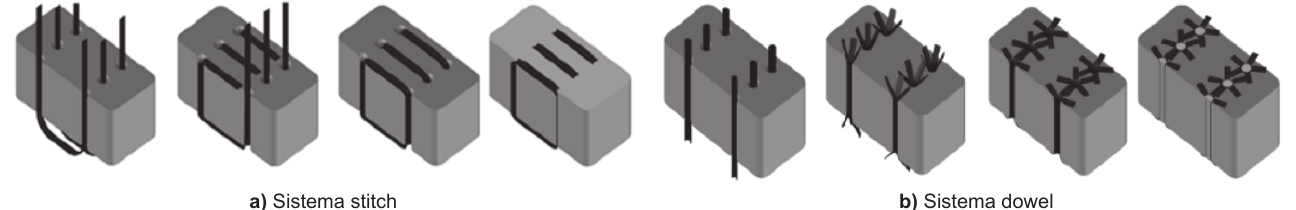
a) Sistema stitch Figura 3 Tipos de reforço à punção para ligações laje-pilar com PRFC (adaptado de Santos [16])